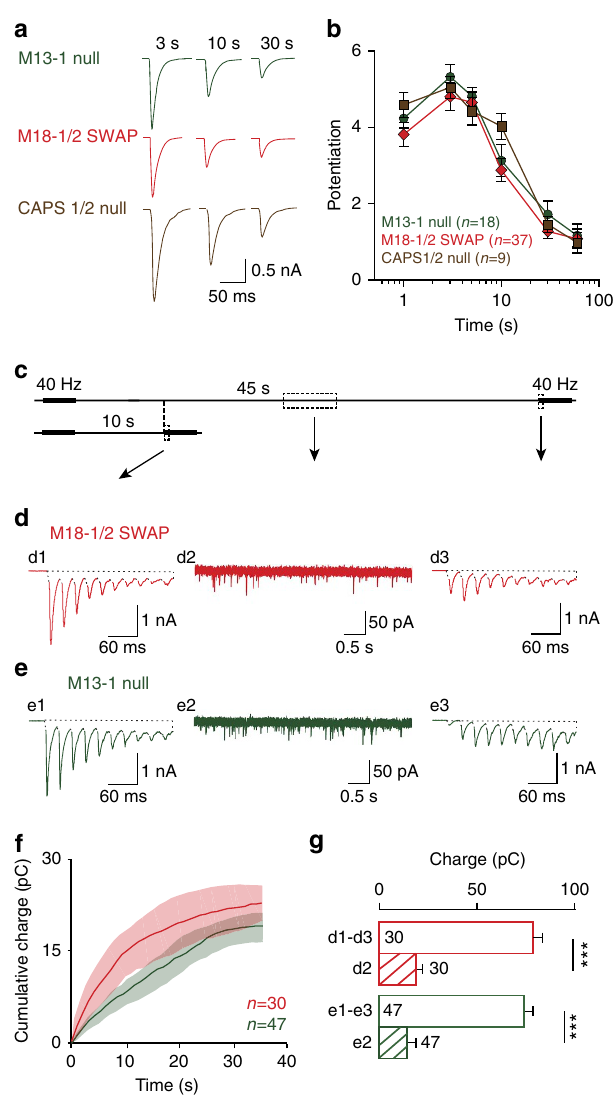
Figure 2 | Primed vesicles rapidly de-prime in the absence of Munc13-1 or Munc18-1. ( a ) Sample traces of evoked EPSCs following 3, 10 and 30s after a priming train (100AP at 40Hz). ( b ) Similar time course of activity- dependent potentiation in munc18-1/2SWAP , munc13-1 null and CAPS-1/2 null synapses. ( c ) Paradigm to assess de-priming (see Methods for details). ( d , e ) sample traces of dual 100AP at 40Hz with 10 or 45s interval in munc18-1/2SWAP ( d ) and munc13-1 null ( e ) synapses. ( f )